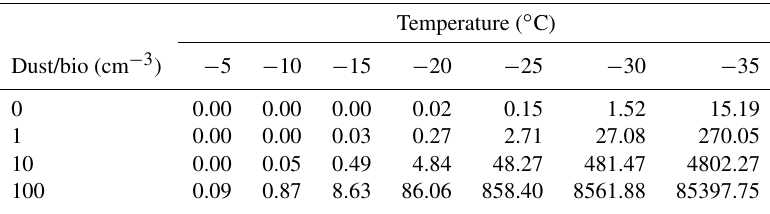
Figure 2. (a) The domain-mean accumulated surface precipitation, and the accumulated (b) rain and (c) snow mass concentrations at the lowest model level ( ∼ 40m above the surface) during the simulation time period for the CMOC case. All domain-mean calculations exclude the lateral boundary grid points in this study. The grey arrow indicates the decrease trend under low INP proxy concentrations, and the magenta arrow is for the increase trend under high INP proxy concentrations. Table 2. INP concentrations (L − 1 ) calculated based on DeMott et al. (2015) under different INP proxy aerosol concentrations (i.e., dust–bio particles in this study) at the various